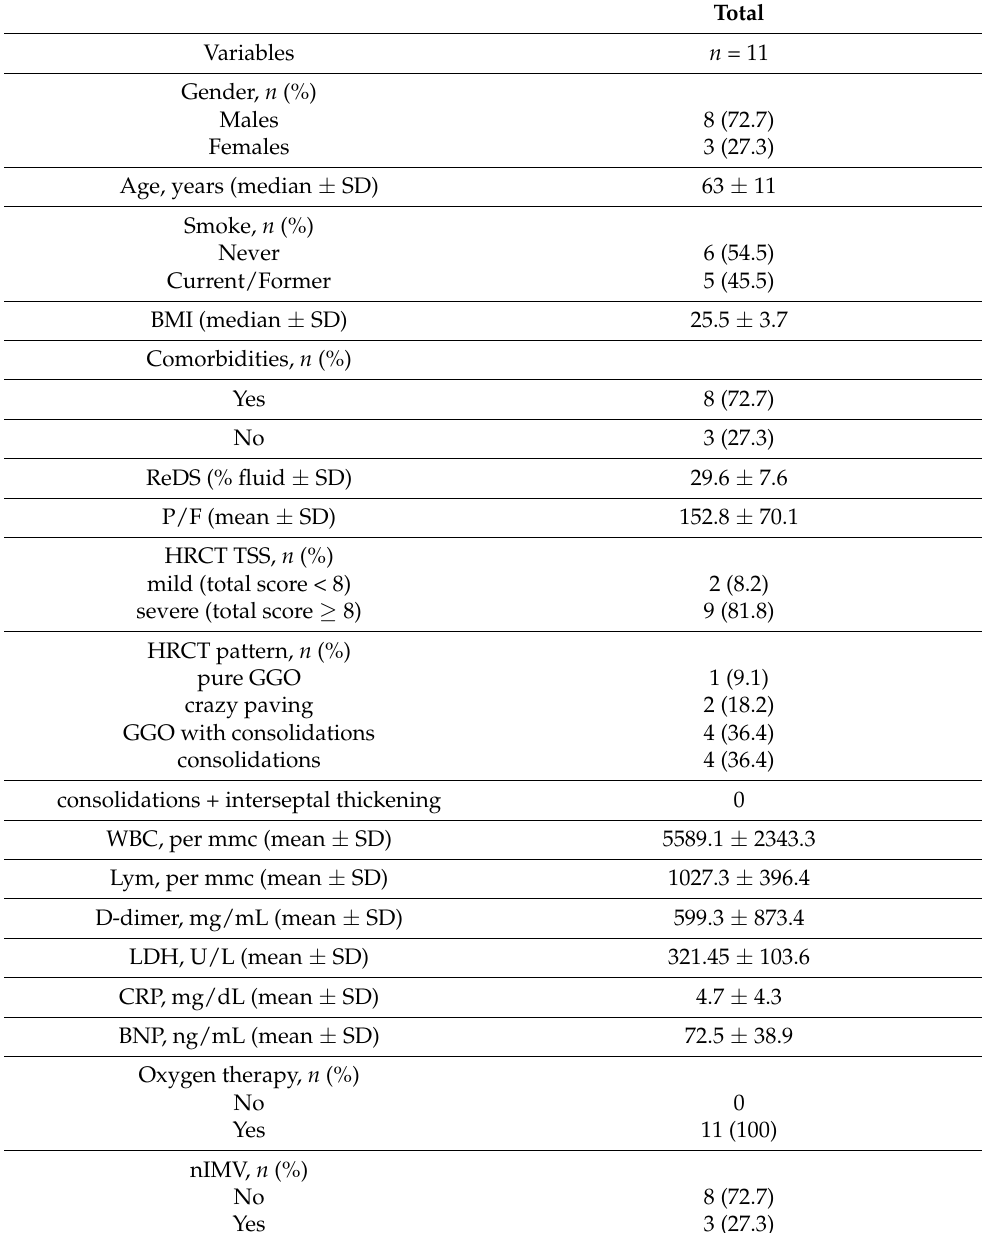
Table 1. Distribution of demographic and clinical characteristics at baseline (on hospital